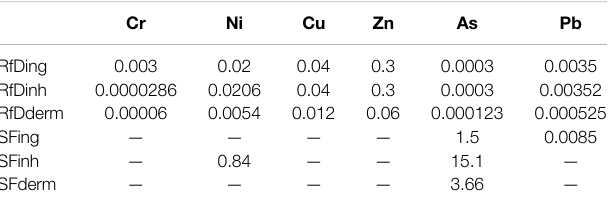
TABLE 1 | Values of reference dose (RfD) [mg · (kgd) − 1 ] and slope factor (SF) [per mg · (kgd) − 1 ] (Chen et al., 2016; Liu et al., 2016; Jiang et al., 2017; Zeng et al., 2019; Yu et al.,